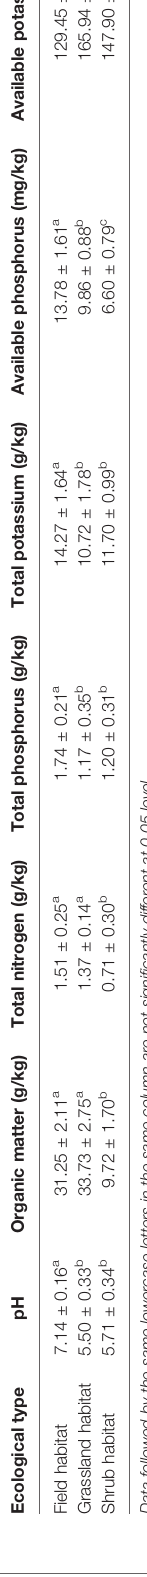
TABLE 1 | Weed composition and management practices at the different experimental sites. Experimental